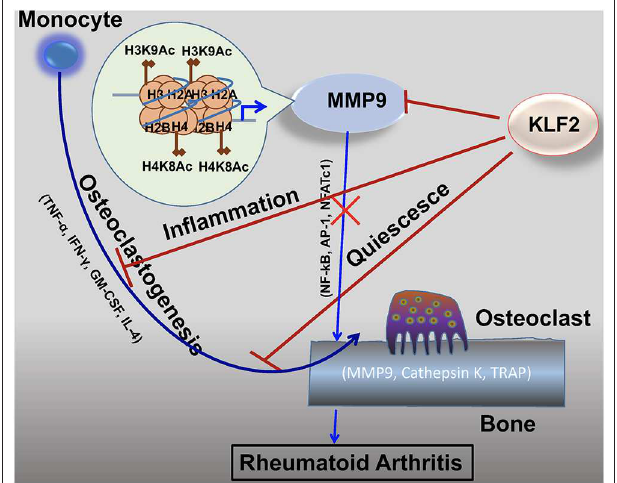
FIGURE 3 | KLF2 attenuates osteoclastogenesis via several complementary mechanisms. KLF2 plays a role in epigenetic modulation of the pro-osteoclastogenic molecule MMP9; data from our lab show that KLF2 knockdown significantly increased enrichment of the active histone marks H3K9Ac and H4K8Ac and respective histone acetylase transfer (HAT) enzymes P300 and PCAF at the enrichment sites for the MMP9 gene ( 80). KLF2 inhibits pro-inflammatory markers, thereby further inhibiting monocytic activation ( 72). Furthermore, KLF2 promotes cell quiescence,